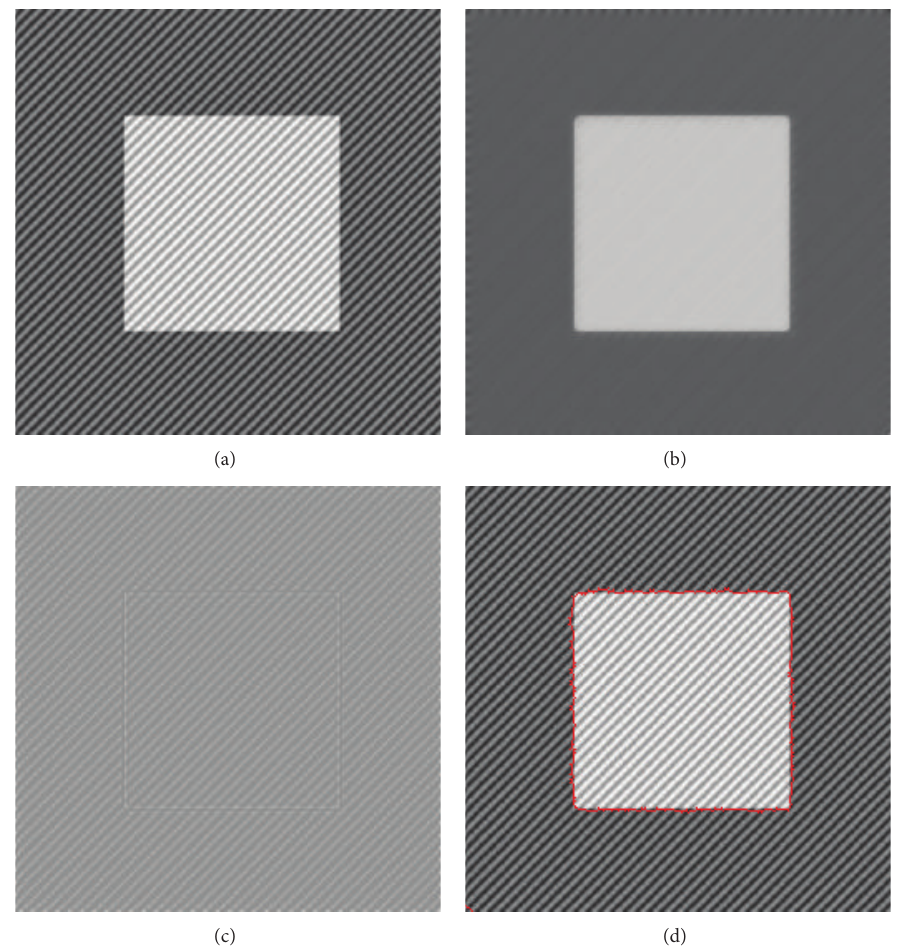
Figure 1: Image for segmentation: (a) original image, (b) the structure part of the image using VO model, (c) the texture part of the image, and (d) the segmentation result.